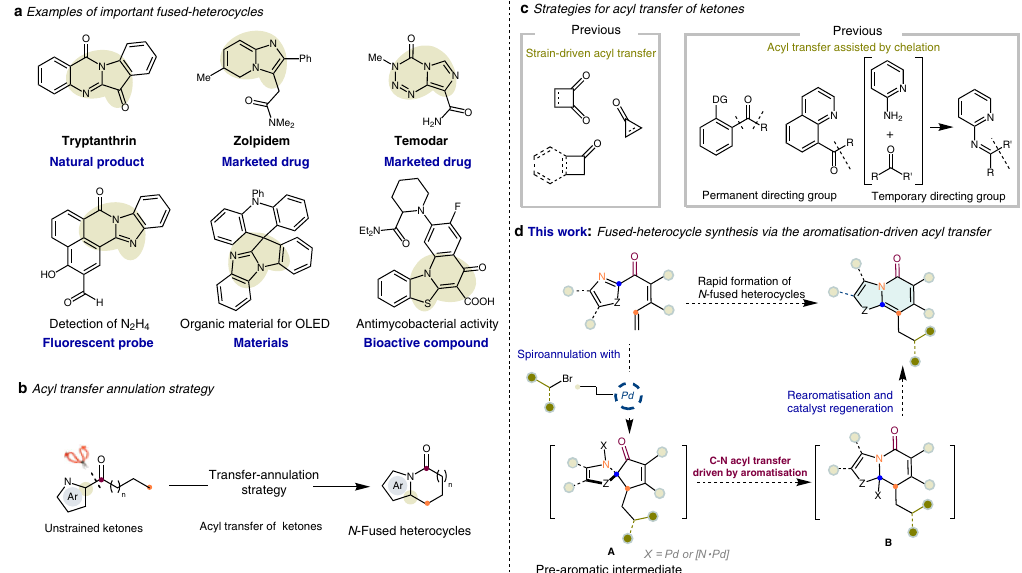
Fig. 1 Examples of critial fused-heterocycles and our reaction design. a N -fused heterocycles are ubiquitous within critical molecules, including biologically active natural and synthetic compounds and fi ne chemicals for use in functional materials. b Transfer-annulation strategy for synthesis of N - fused heterocycles. c Different strategies used in acyl transfer of ketones. d Fused heterocycle synthesis in this study via aromatisation-driven acyl tranfer of heteroaryl ketones with alkyl